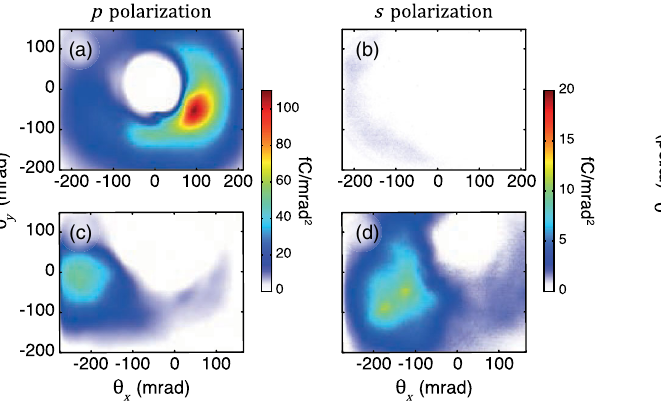
FIG. 5. Reflected fundamental beam and evolution of the plasma reflectivity. Using a scattering screen, the spatial intensity profile of the laser beam reflected by the target can be measured. The two panels (a) and (b) show typical beam profiles respec- tively obtained in the short (upper image, L 1 ¼ λ = 15 ) and long (lower image, L 2 ¼ λ = 1 . 5 ) density gradient regimes, for p polarization of the incident laser. In all cases, the laser incidence angle is θ i ¼ 55 ∘ . The black dashed circles indicate the initial divergence of the top-hat laser beam, before its interaction with the target. From the spatial integration of these images, the reflectivity of the plasma for the fundamental laser frequency can be determined, and is plotted in (c) as a function of L for both s and p polarizations (squares and circles). The lines show the corresponding results of 2D particle-in-cell simulations (see Sec. V